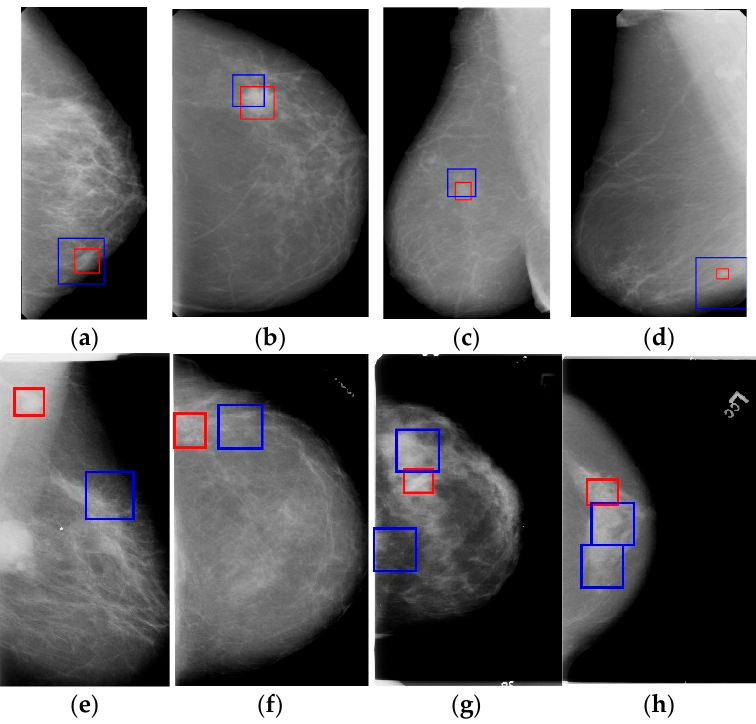
Figure 8. Detection results on CBIS-DDSM by the proposed detection framework. The red rectangles indicate the ground truth of masses while the blue rectangles stand for the detection results. ( a )